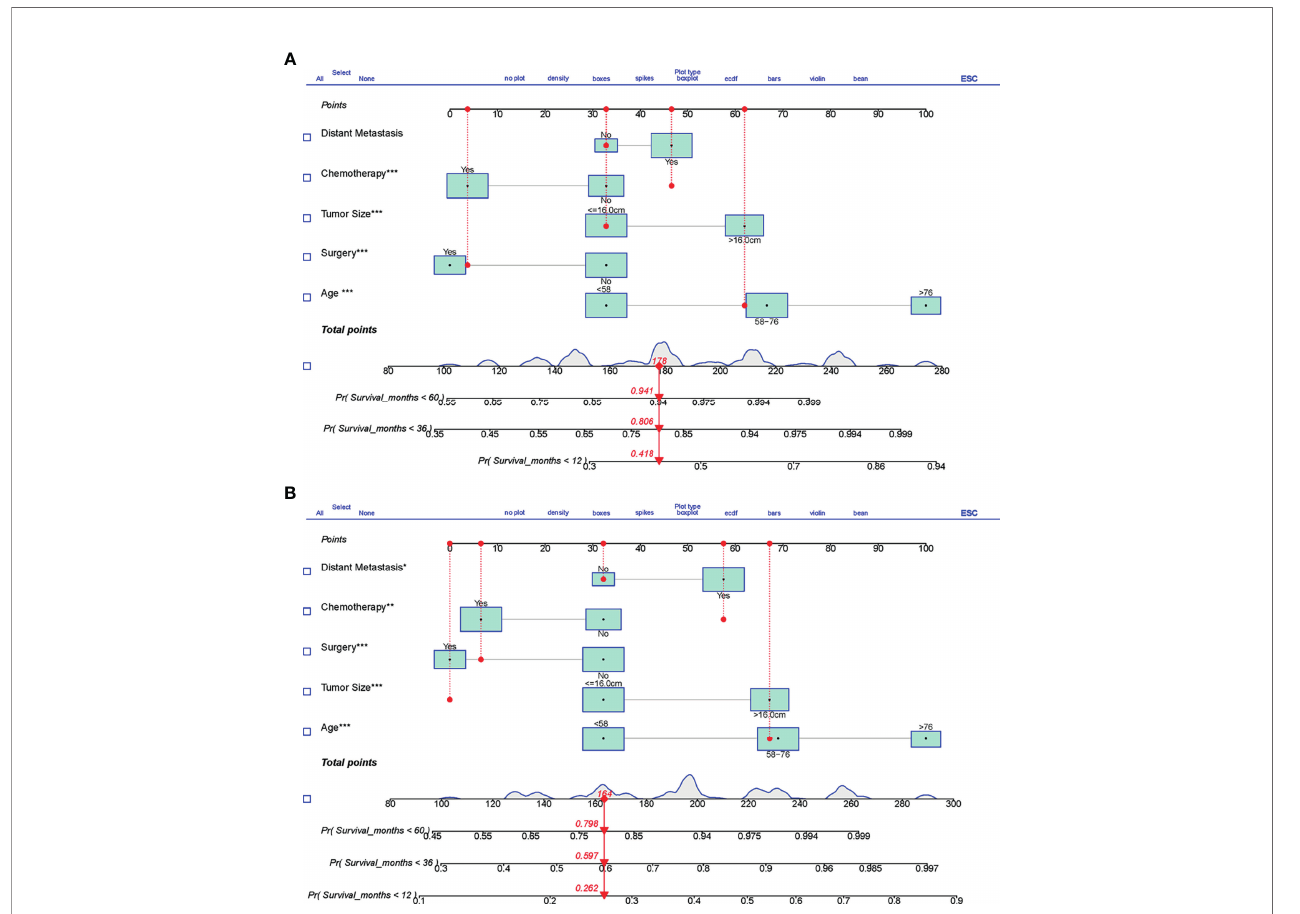
FIGURE 5 | The prognostic nomograms predicting 1-, 3-, and 5-year survival for LMS patients with metastasis. (A) Nomogram for OS. (B) Nomogram for CSS. LMS, leiomyosarcoma; OS, overall survival; CSS, cancer-speci fi c survival. The symbols *, ** and *** means the importance of this variable for the prognostic nomograms. They represent important, very important and extremely important, respectively. ROC, receiver operating curve; OS, Overall